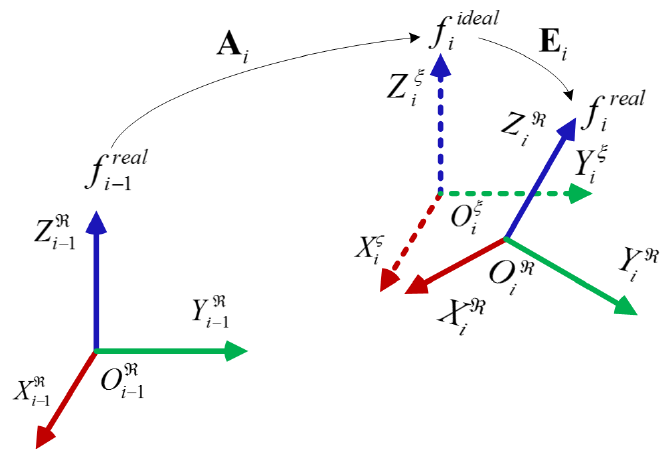
Figure 1. Frame translation and rotation due to the errors for the i th